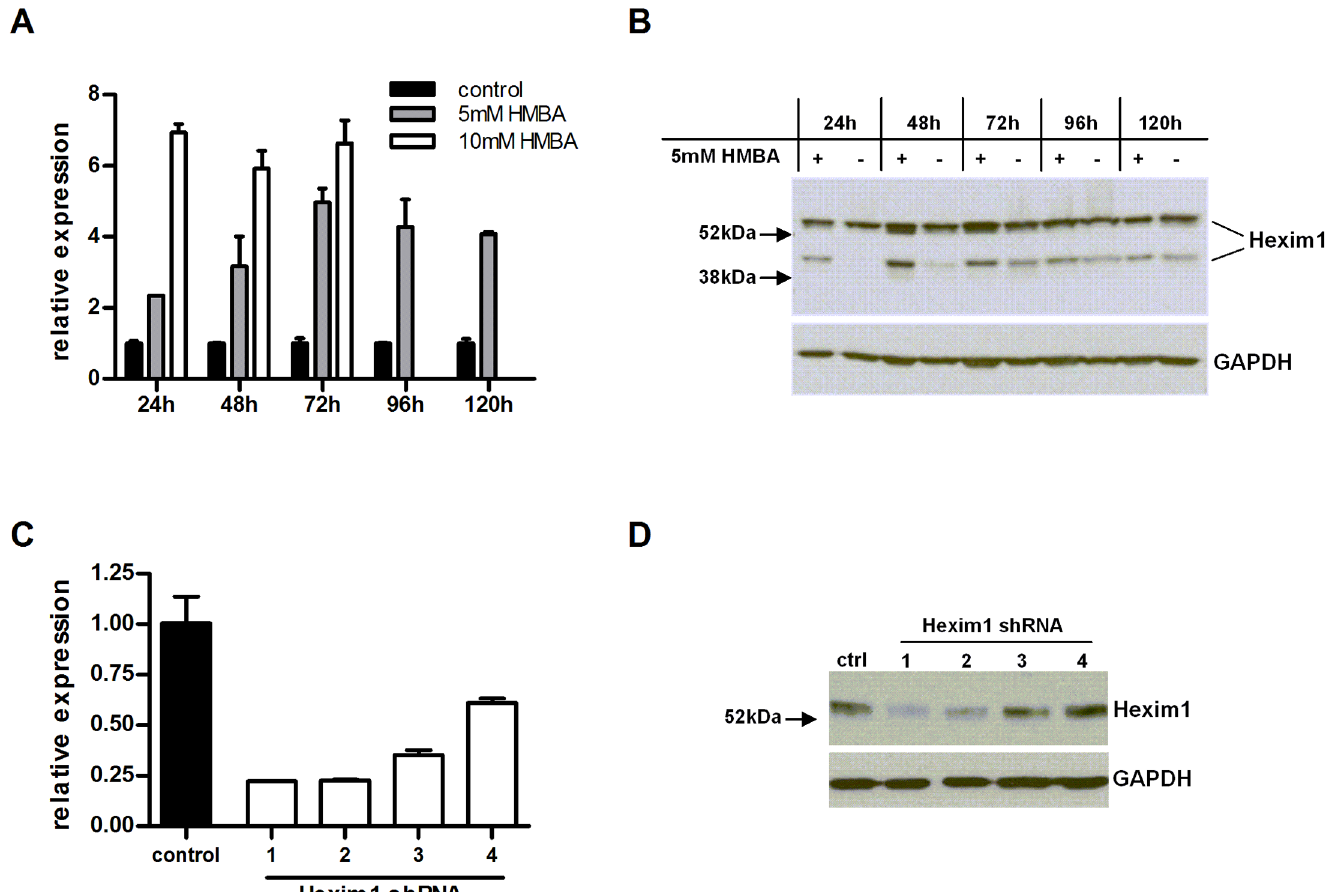
Fig 6. Confirmation of up- or downregulation of Hexim1. Upregulation of Hexim1 was accomplished by stimulation of NIH 3T3 cells with HMBA, and the expression of Hexim1 was analyzed by quantitative PCR on mRNA level (A) and by Western Blot on protein level (B). In addition to the predicted 54 kDa band, a second band at approximately 40 kDa was detected by Western Blot with lysates from NIH 3T3 cells, probably representing a modified form of the protein. To downregulate Hexim1, stable cell lines of TCMK-1 cells expressing shRNA specific for Hexim1 were generated. Downregulation of Hexim1 in these cell lines was confirmed by quantitative PCR (C) and by Western Blot (D). The shRNAs 1 and 2 proved to be most effective regarding downregulation of